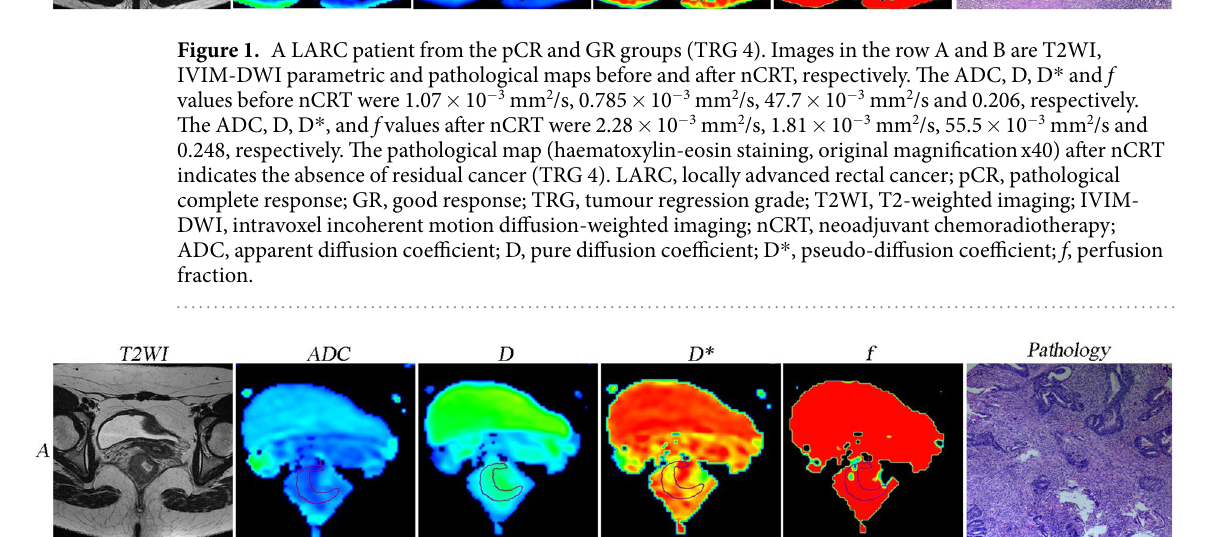
6 Scientific RepoRts | 7: 8496 | DOI:10.1038/s41598-017-09227-9